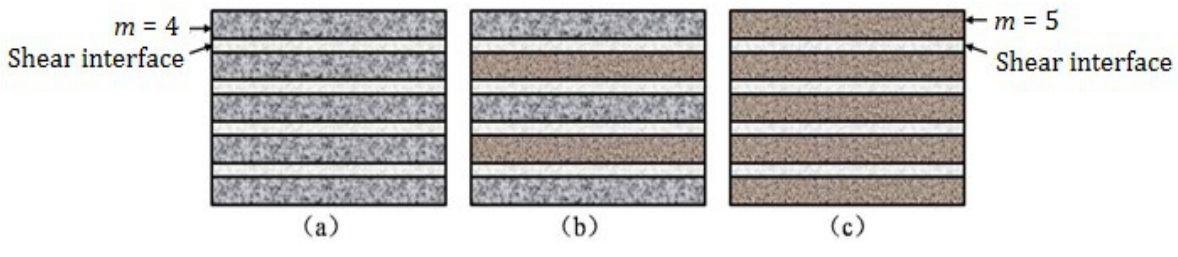
Ti O ; ( c ) SrLa 8 9 31